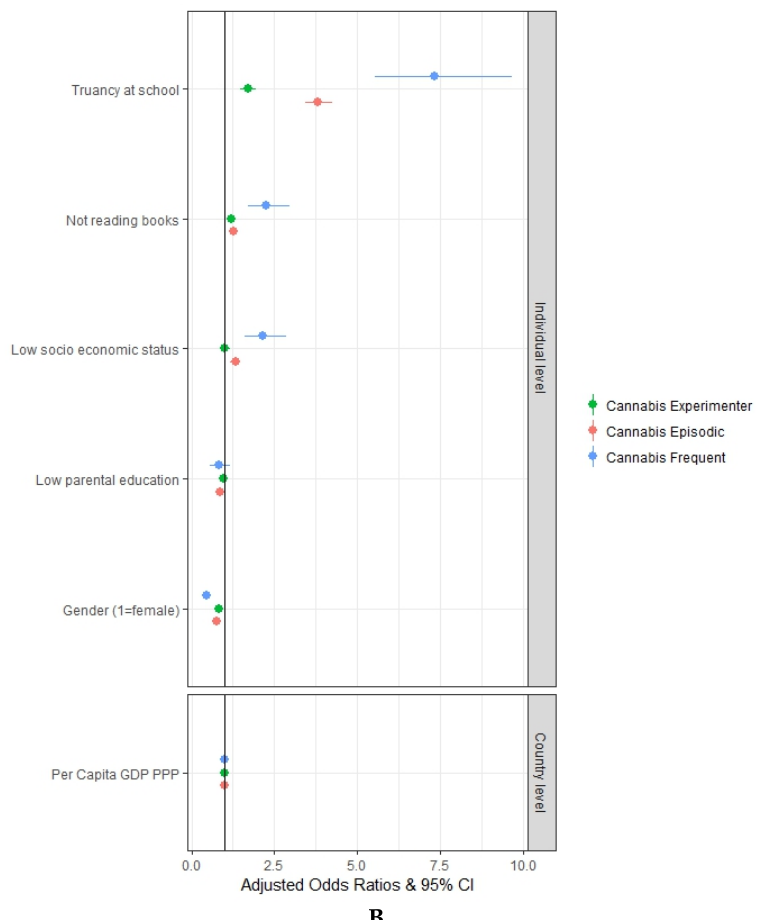
Figure 1. Multivariate multilevel mixed-effects logistic regression adjusted odds ratios with a 95% confidence interval: ( A ) relation between students’ socioeconomic status, parental education and the patterns of cannabis use (Experimenter, Episodic and Frequent); ( B ) relation between students’ socioeconomic status, parental education, truancy at school, reading books for enjoyment and the patterns of cannabis use (Experimenter, Episodic and Frequent). Authors’ elaboration on ESPAD data.